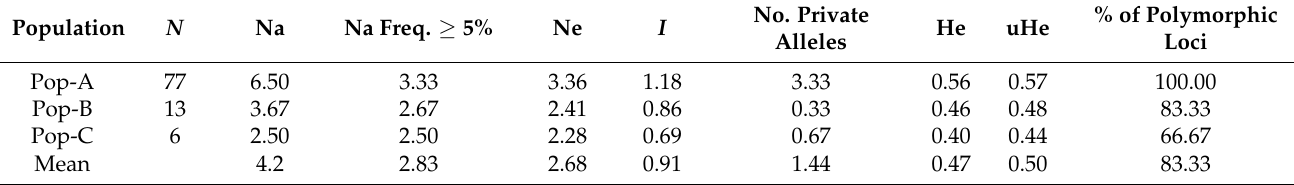
Table 3. Genetic diversity estimates for three populations of D. rabiei based on six microsatellite (SSR)